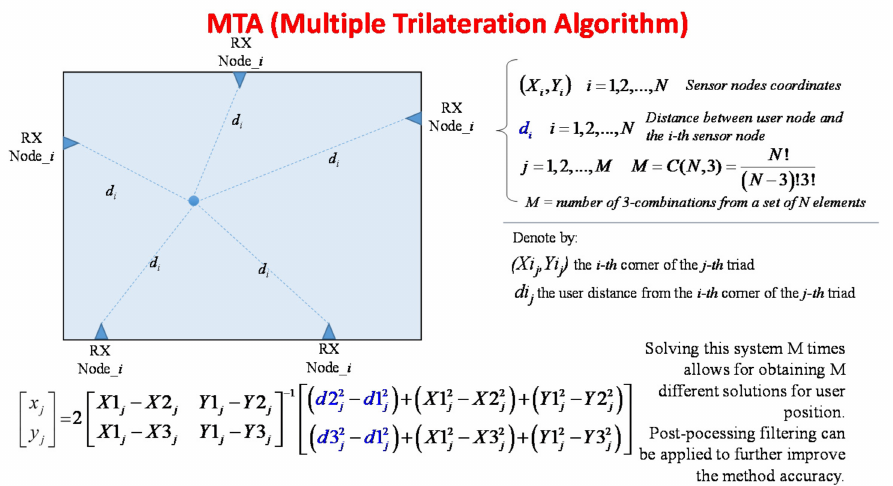
Figure 1. Schematization of the MTA algorithm. M potential coordinates of the user in the plane, ( x j , y j ), are estimated by considering all allowed triads of sensor